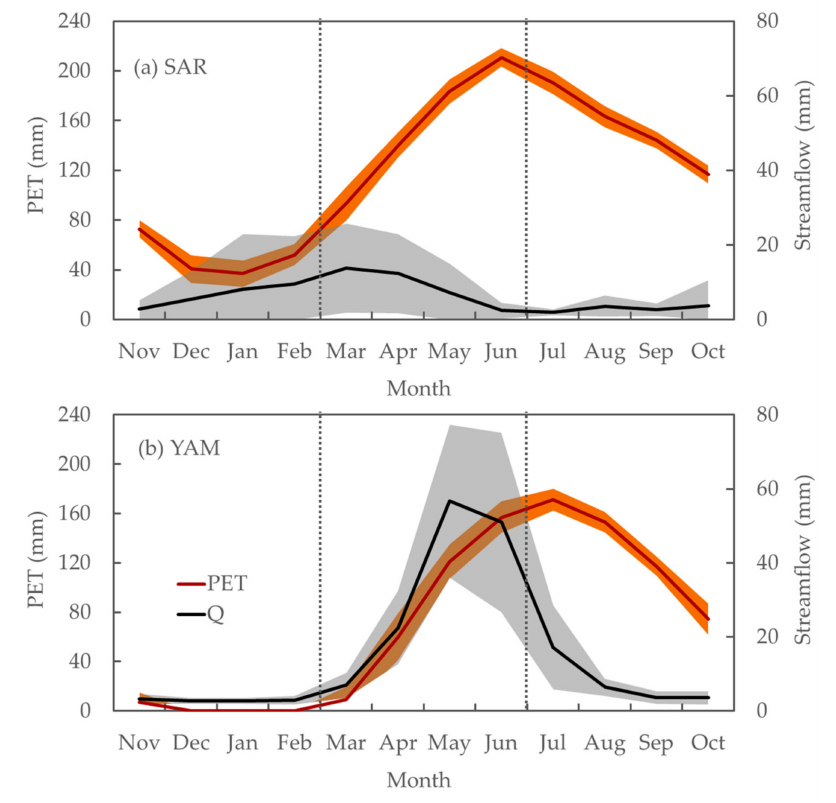
Figure 10. Comparison of peak water availability and energy demand in Lower Colorado River Basin (LCRB) and Upper Colorado River Basin (UCRB). Plots of mean (lines) and standard deviation (shaded areas) of streamflow (Q) and potential evapotranspiration (PET) for Salt River (SAR) in LCBR ( a ) and the Yampa River (YAM) in UCRB ( b ) from 1968–2011. To better illustrate basin differences, the scale of streamflow is magnified 3-fold relative to PET. PET from TerraClimate